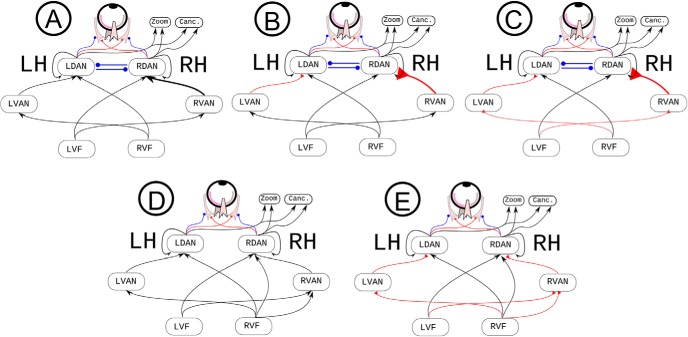
A–C, Different implementations of the attentional networks with interhemispheric inhibition (Koch et al., 2011) and DAN/VAN architecture (Corbetta and Shulman, 2002). D, E, Two implementations of right-hemisphere networks with bilateral competence (Heilman and Van Den Abell, 1980; Mesulam, 1981) and no interhemispheric inhibition. Arrows indicate connections that can be either excitatory or inhibitory; red connections with triangular arrowheads denote excitatory connections; blue round arrowheads represent inhibitory connections. LH, left hemisphere; RH, right hemisphere; Canc., cancellation units; LDAN and RDAN, dorsal attention networks in the left and in the right hemisphere, respectively; LVAN and RVAN, ventral attention networks in the left and in the right hemisphere; LVF and RVF, left and right visual field. Right and left VANs have the same number of neurons but different patterns of connection strength.